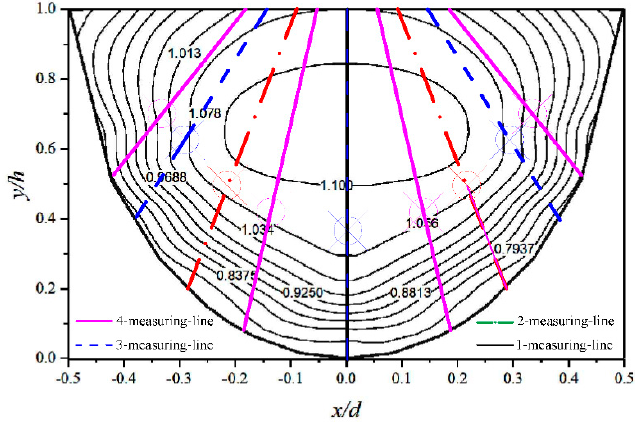
Figure 7. Schematic diagram of flow measurement with different number of measuring lines (C2).